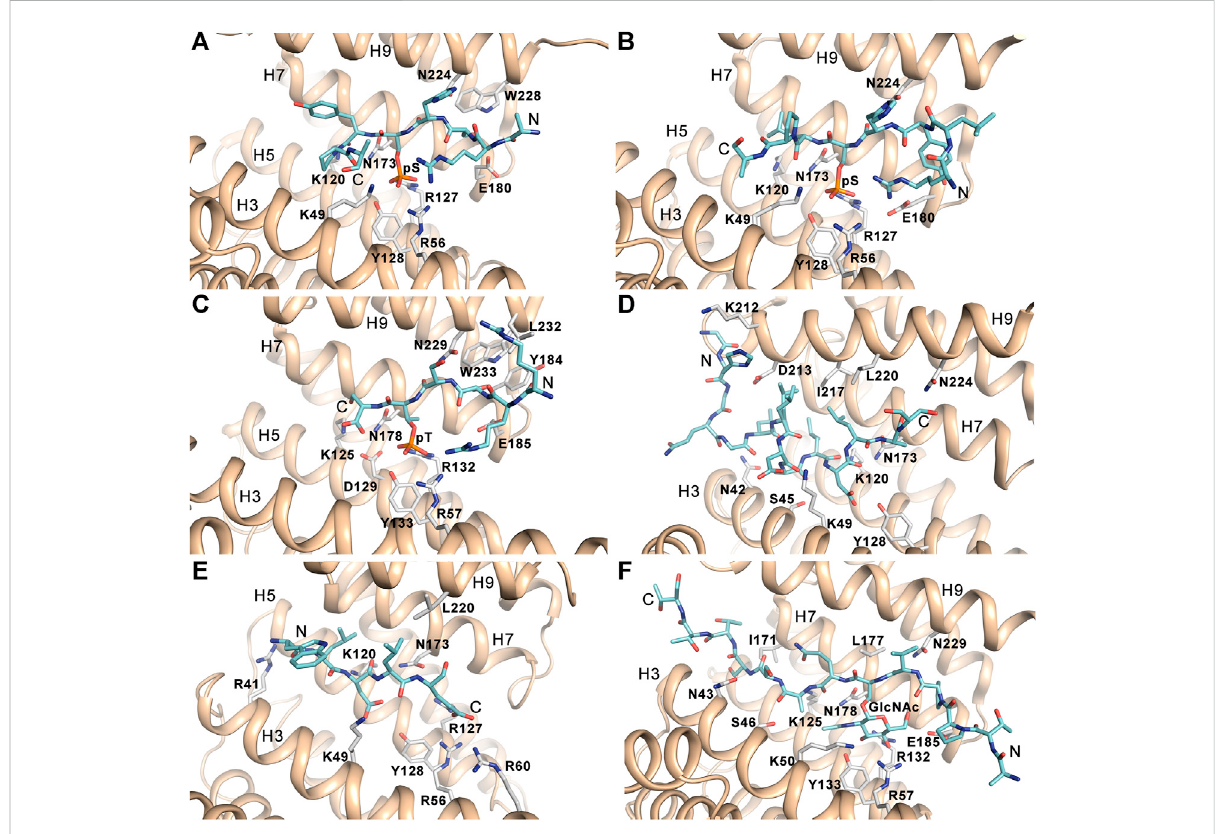
FIGURE 2 14-3-3 binding motifs. (A) The canonical mode I phosphopeptide (sequence ARSH(pS)YPA) bound to 14-3-3 ζ (PDB ID: 1QJB) (Rittinger et al., 1999). (B) ThecanonicalmodeIIphosphopeptide(sequenceRLYH(pS)LPA)boundto14-3-3 ζ (PDBID:1QJA)(Rittingeretal.,1999). (C) Thecanonical mode III phosphopeptide derived from the C-terminus of human DAPK2 (sequence RRSS(pT)S) bound to 14-3-3 γ (PDB ID: 7A6R) (Horvath et al., 2021). (D) Thenon-phosphorylatedExoSpeptide(sequenceGHGQGLLDALDLAS)boundto14-3-3 ζ (PDBID:2O02)(Ottmannetal.,2007b). (E) The non-phosphorylated R18 peptide derived from phage display (sequence WLDLE) bound to 14-3-3 ζ (PDB ID: 1A38) (Petosa et al., 1998). (F) The glycosylated Ser-O-GlcNAc peptide (sequence ATPPV(S-O-GlcNAc)QASSTTT) bound to 14-3-3 γ (PDB ID: 6BYJ) (Toleman et al., 2018). The fi gure was prepared with PyMOL